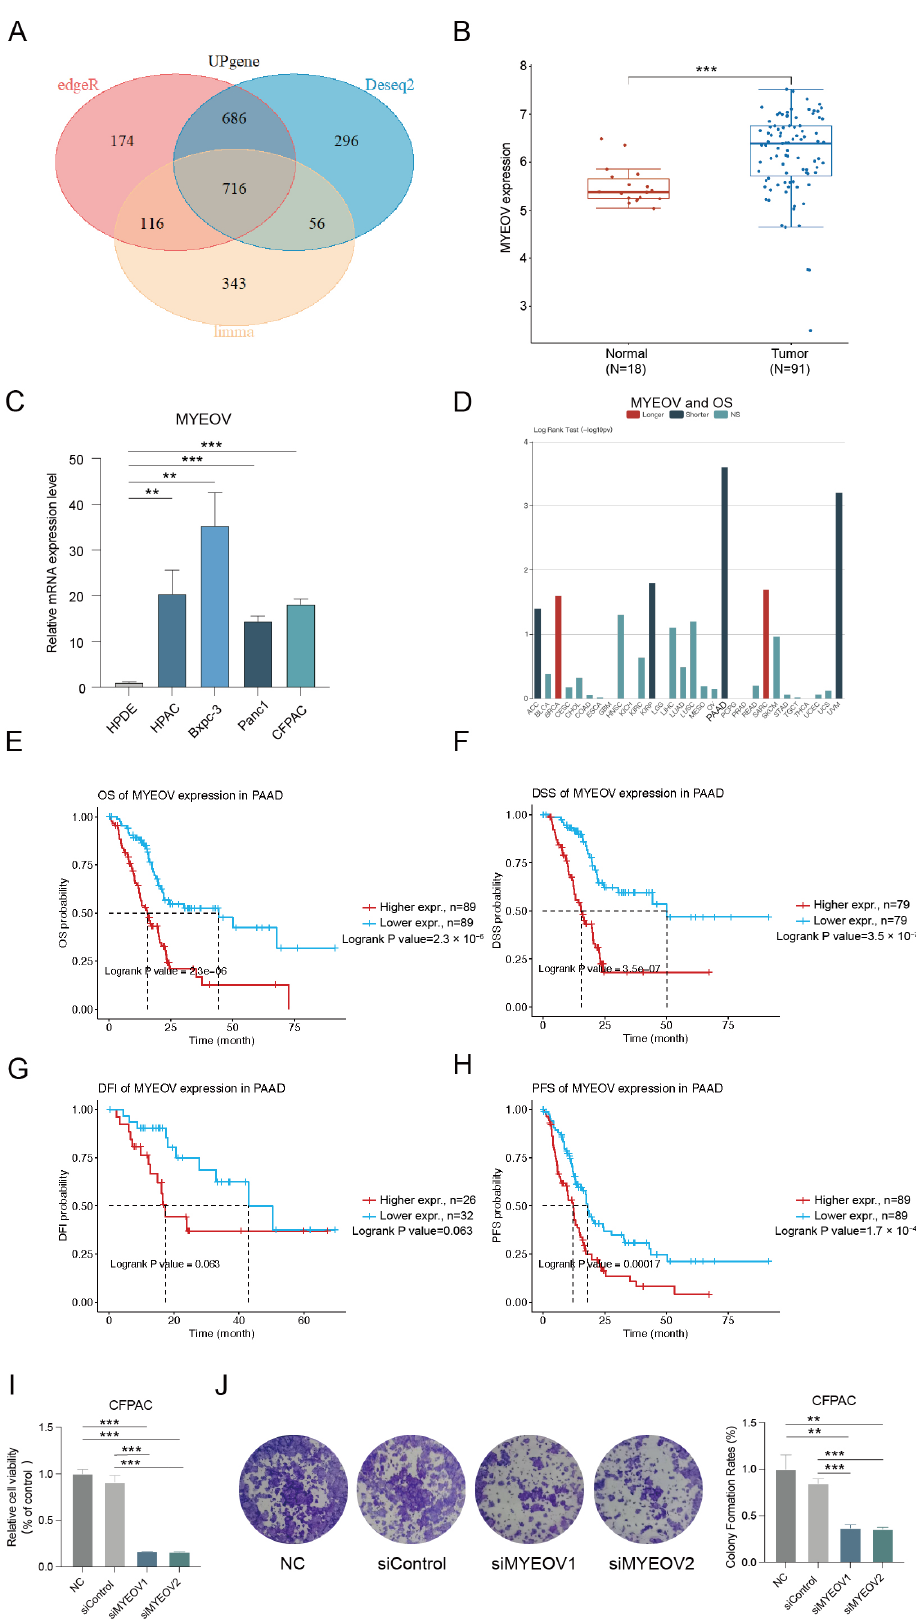
Figure 1. MYEOV was found to be a key upregulated gene associated with pancreatic cancer. ( A ) Intersection was performed to obtain the upregulated genes simultaneously analyzed by